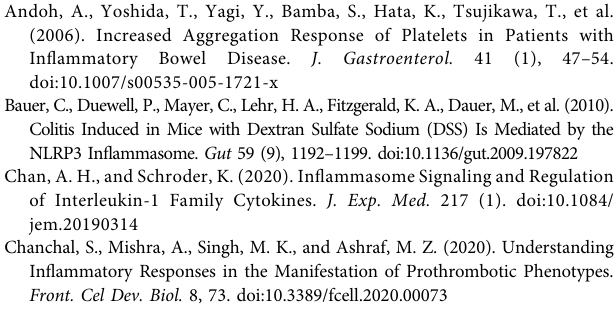
Supplementary Figure 1 | The mRNA levels of caspase-1 in platelets from the healthy group and patients with active Crohn ’ s disease (CD). (A) The mRNA levels of caspase-1 were determined by RT-PCR in platelets from the healthy group ( n (cid:2) 17) and patients with active CD ( n (cid:2) 17). Health, the healthy group; CD, the patients with active CD. Data are presented as mean ± SD, n.s. p > 0.05. Supplementary Figure 2 | Correlation between ROS levels or NLRP3 in fl ammasome components and P-selectin exposure or fi brinogen binding in platelets from patients with active Crohn ’ s disease (CD). (A) The ASC protein levels were positively correlated with P-selectin exposure in platelets from patients with active CD ( n (cid:2) 26). (B) The ASC protein levels were positively correlated with fi brinogen binding in platelets from patients with active CD ( n (cid:2) 26). (C) The active caspase-1 protein levels were positively correlated with P-selectin exposure in platelets from patients with active CD ( n (cid:2) 26). (D) The active caspase-1 protein levels were not correlated with fi brinogen binding in platelets from patients with active CD ( n (cid:2) 26). (E) The ratio of interleukin- 1 β -positive platelets was positively correlated with P-selectin exposure in platelets from patients with active CD ( n (cid:2) 26). (F) The ratio of interleukin- 1 β -positive platelets was positively correlated with fi brinogen binding in platelets from patients with active CD ( n (cid:2) 26). (G) The ROS levels were positively correlated with P-selectin exposure in platelets from patients with active CD ( n (cid:2) 26). (H) The ROS levels were positively correlated with fi brinogen binding in platelets from patients with active CD ( n (cid:2)